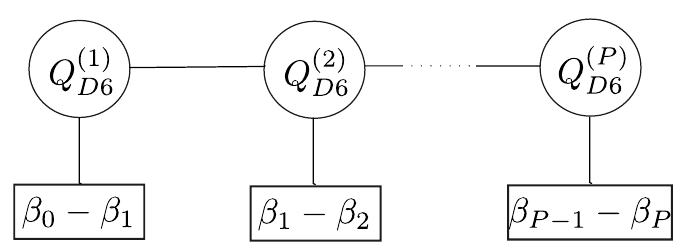
Figure 1 . Quiver describing the field theory living in D6-NS5-D8 intersections. The circles denote (1 , 0) vector multiplets and the lines (1 , 0) bifundamental matter fields. The quiver has been terminated with ( β ) D8-branes at the end of the space, with β P − 1 − β P γ P = − 81 π 2 P P − 1 β l l =1